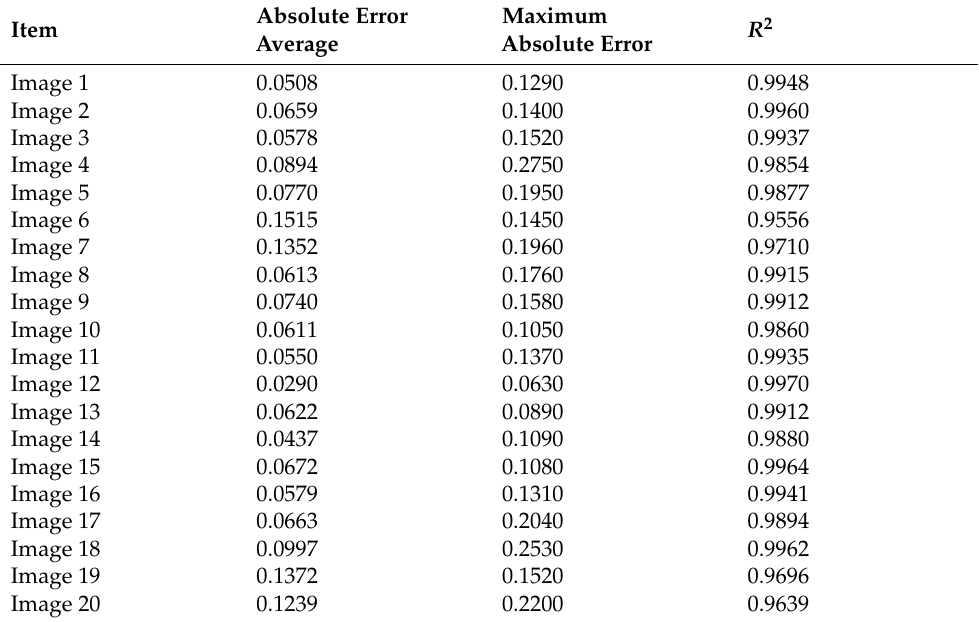
Table 6. The error of the proposed measurement system in 20 positions